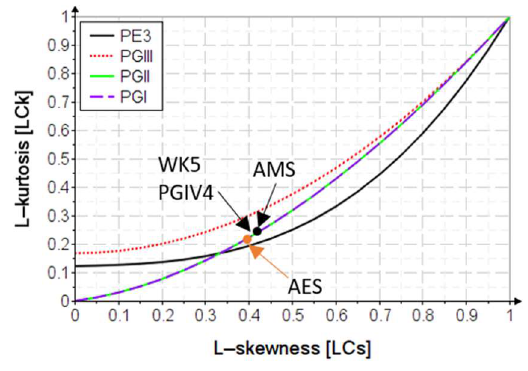
  Figure 6. The τ 3 − τ 4 diagram for analyzed distributions. Figure 6. The 3 4 diagram for analyzed distributions.